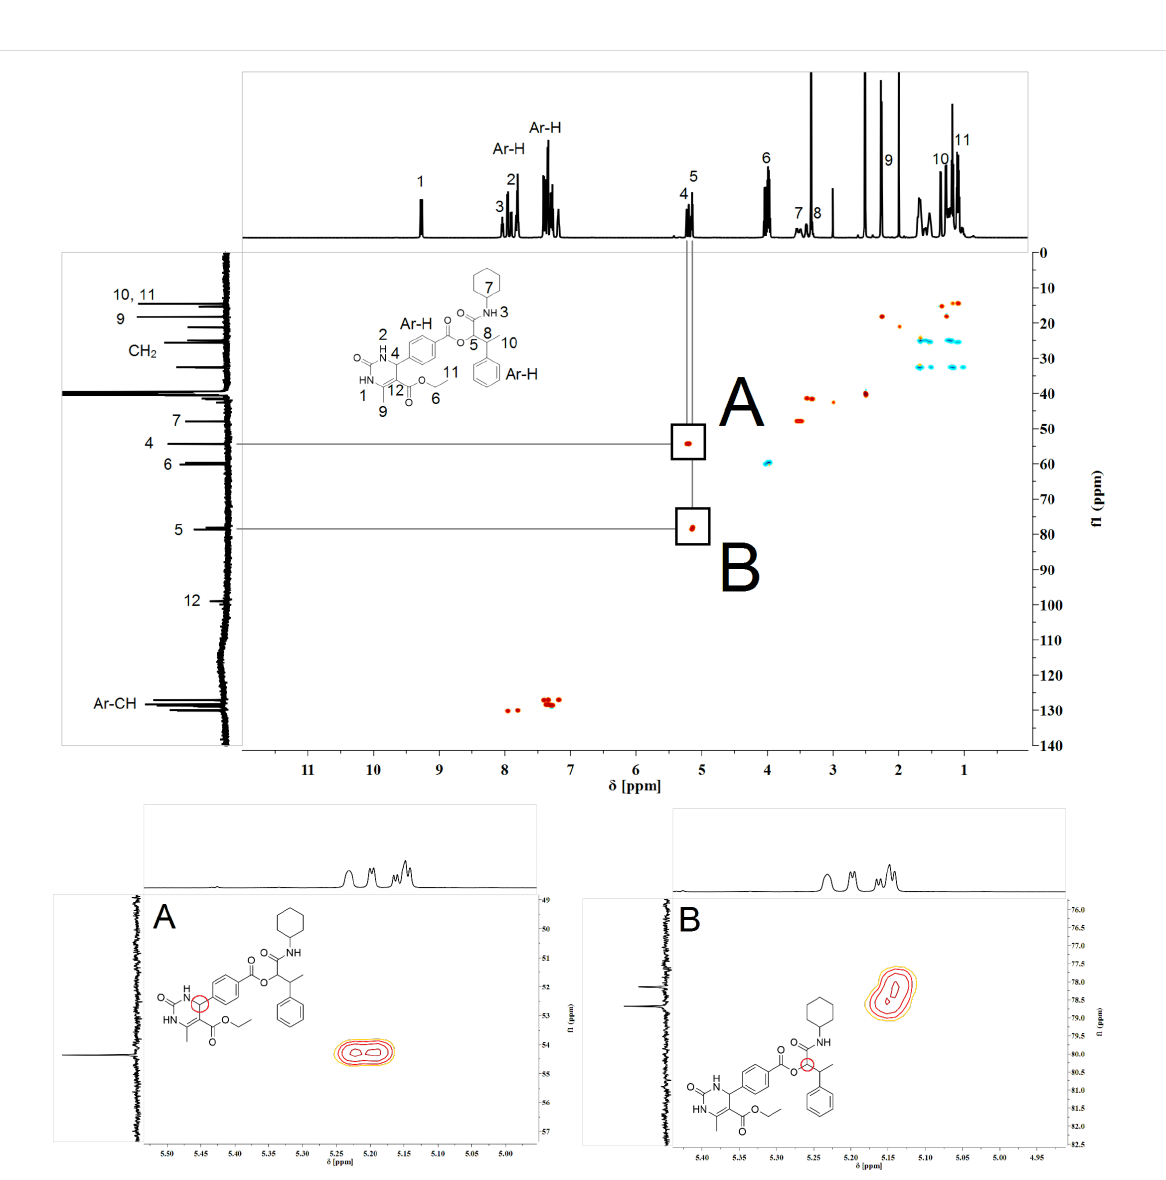
Figure 3: Representative HSQC spectrum of the pure Biginelli–Passerini tandem product 21 , expansions and signal assignment for two asymmetric carbon atoms. A: Diastereomeric signal splitting in 1 H NMR solely. B: Diastereomeric splitting in both 1 H and 13 C NMR, two different species can be identified.